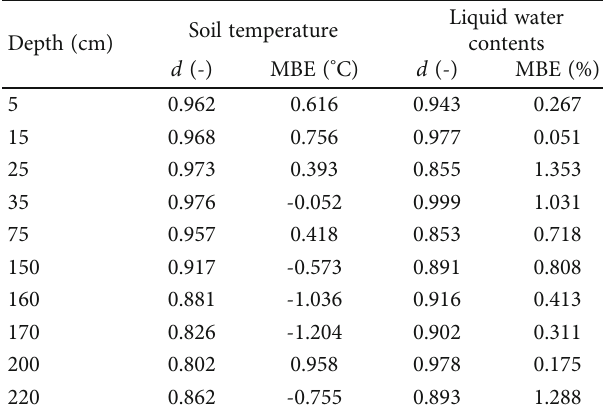
Table 2: Summary statistics for di ff erences between the measured and simulated values at di ff erent depths